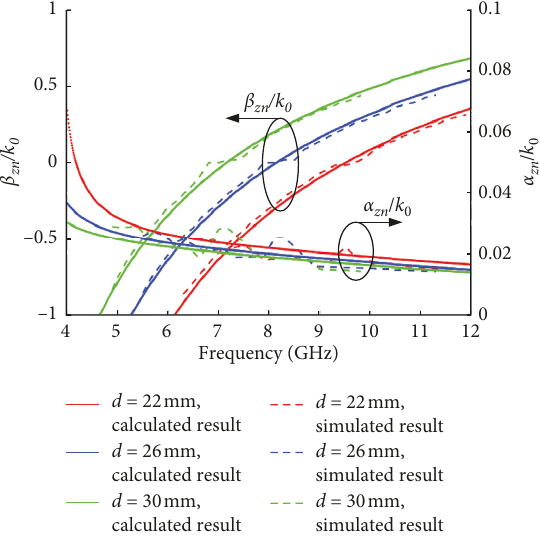
Figure 6: The propagation constants calculated by (3) ∼ (11) and simulated by HFSS of the proposed antenna with different d ( W 26mm). (cid:31) (cid:31)